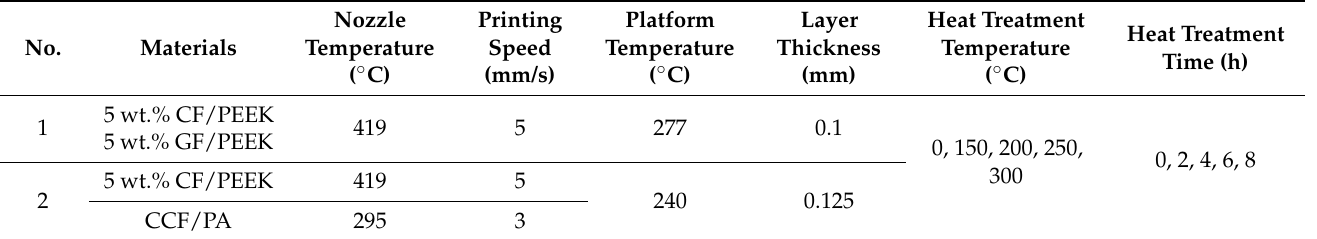
Table 1. FDM 3D printing and heat treatment process